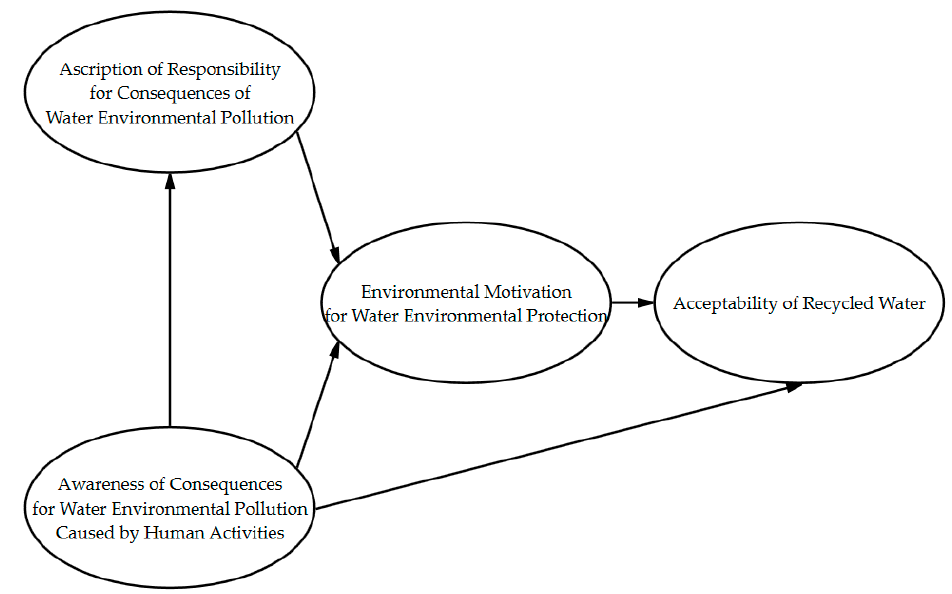
Figure 2. Logic frame diagram of recycled water reuse behavior NAM.